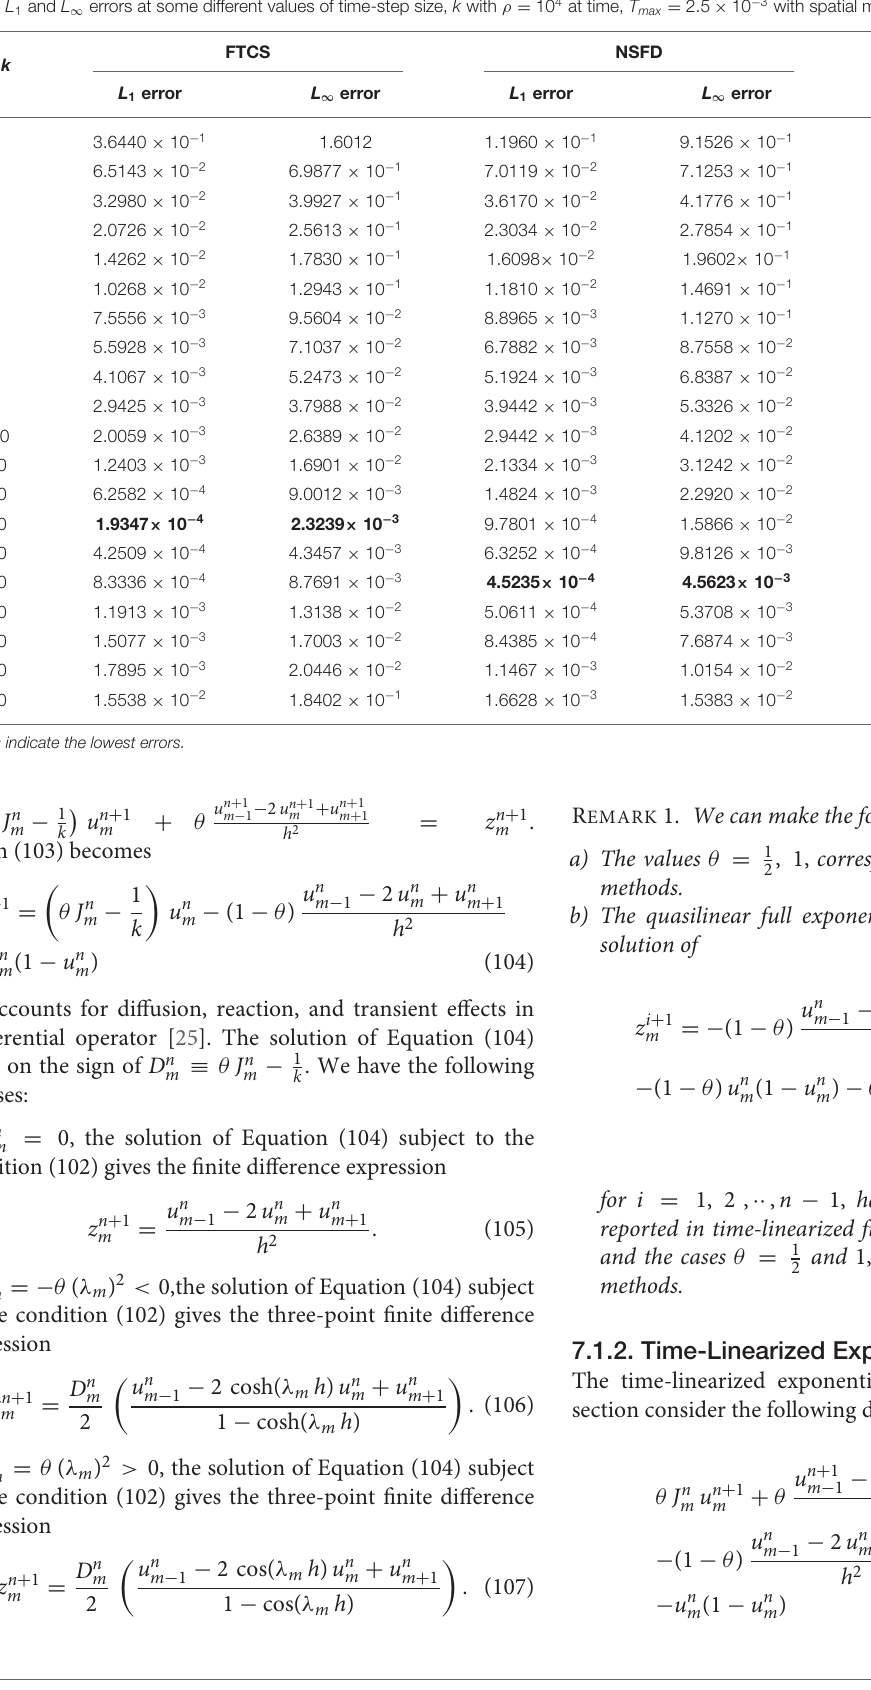
errors at some different values of time-step size, k with ρ ∞